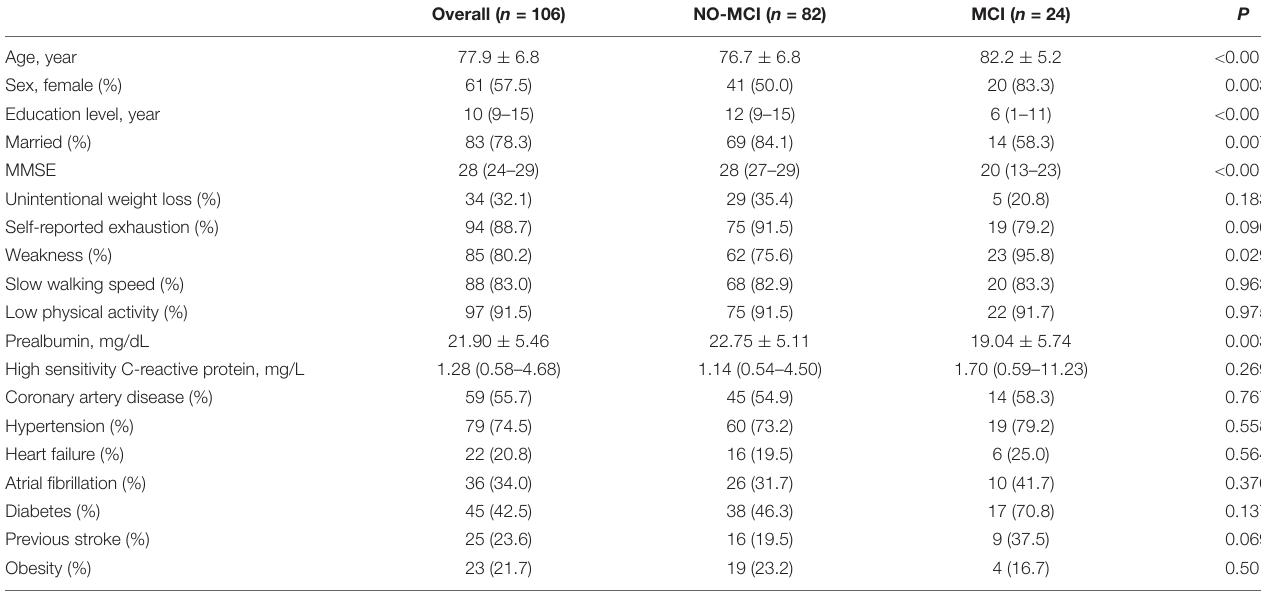
TABLE 1 | The baseline characteristics of study participants by cognitive function status.